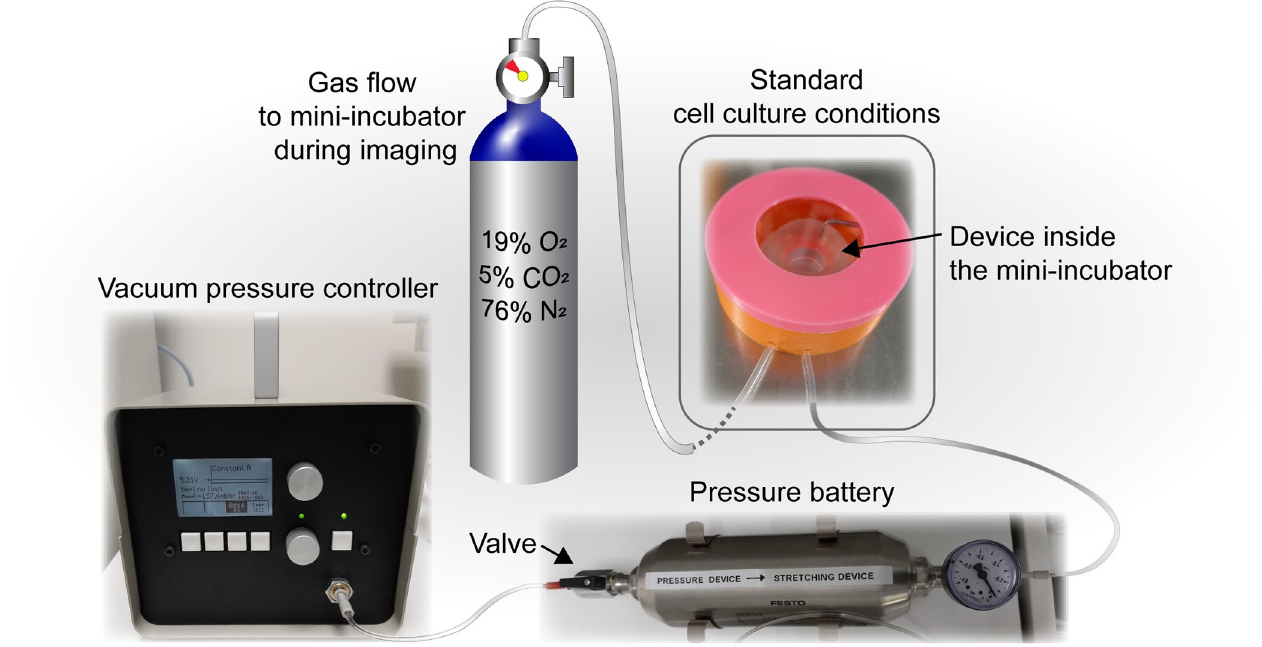
Fig 2. The experimental setup. The device was set inside the mini-incubator and connected to the vacuum pressure controller. The vacuum battery was attached between the device and the vacuum pressure controller. During the cell culture period the mini-incubator containing the device was kept inside a standard cell culture incubator. The valve of the vacuum battery was opened, thus allowing the vacuum pressure controller to maintain pressure during cell culture. After the six-day cell culture period during transportation to the microscope, the valve of the vacuum battery was closed, which allows the setup to be momentarily detached from the vacuum pressure controller as the vacuum battery maintains the vacuum pressure. At the microscope, the device was again connected to the vacuum pressure controller and the valve was opened. Gas flow (5% CO 2 ) to the mini-incubator was initiated once the device was removed from the standard incubator to maintain pH during transportation and imaging. Heated gas to maintain the temperature during the imaging was supplied into the microscope stage top